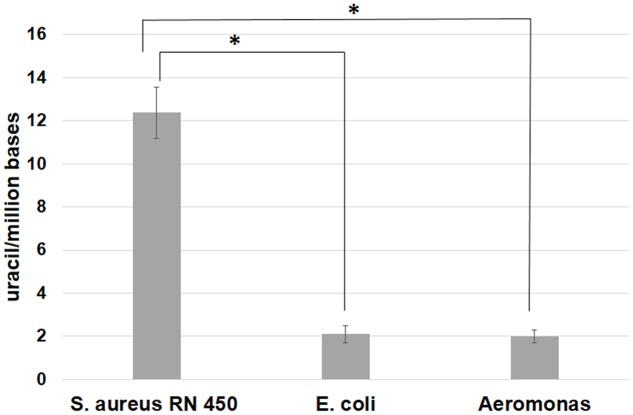
Genomic uracil-DNA content of Staphylococcus aureus RN450, Escherichia coli (ATCC 25922), and Aeromonas hydrophila (ATCC 7966) strains. Results were obtained using the uracil-DNA quantification method as described previously (Rona et al., 2016). Significant increase (∗) in uracil-DNA content was observed in the data for the S. aureus 450 strain as compared to the E. coli and Aeromonas hydrophila strains (P < 0.05). Calculations were based on three independent datasets, representing three different biological samples.